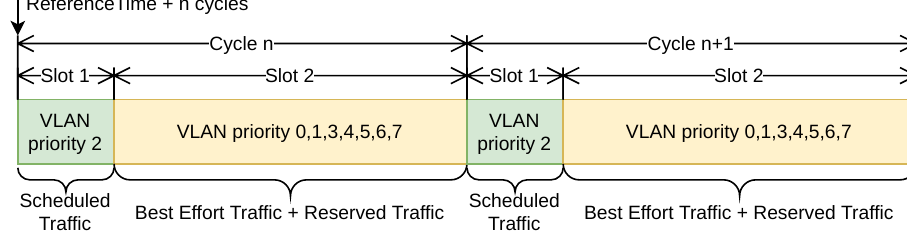
Figure 3. Example of a TSN time-slot division.